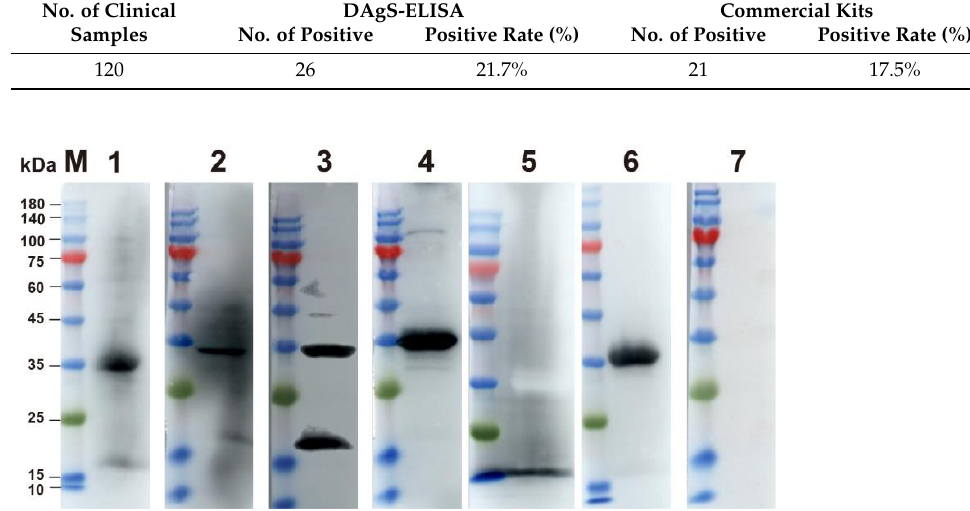
Table 3. Comparison results of DAgS-ELISA and commercial kits.